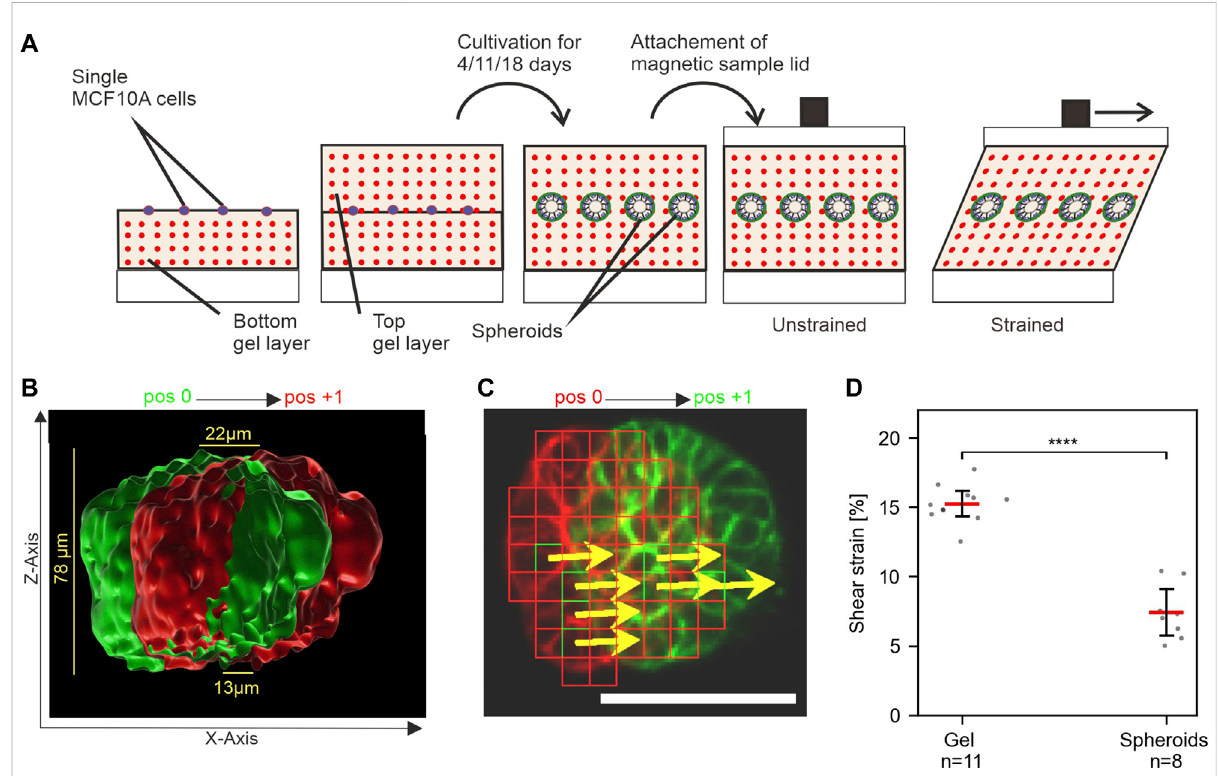
FIGURE 4 MCF10A spheroids show resistance to mechanical shear strain. (A) Schematic of the experimental setup to apply shear strain on hydrogel- embedded MCF-10A spheroids. Single cells are seeded between two layers of gel and cultivated upon the desired maturation stages. The magnetic lidisattachedbeforestressapplication. (B) Surface-renderedimageoftheactincytoskeleton(LiveactRFP)ofarepresentativespheroidinunstrained (green) and strained (red) positions. The cross-section view highlights its height-dependent displacement. (C) Automated detection of displaced cellular actin structures for an individual focal plane. Displacement vectors (DVs) (yellows arrows) are given for templates (red squares). Scale bar: 50 µm (D) Measured strain amplitudes for spheroids and their surrounding gel at npositions ina single sample. Scatter plots: bars: median with 95% con fi dence interval. For statistical tests, Mann – Whitney U -test was used with: **** = p ≤ 0.0001, *** = p ≤ 0.001, * = p ≤